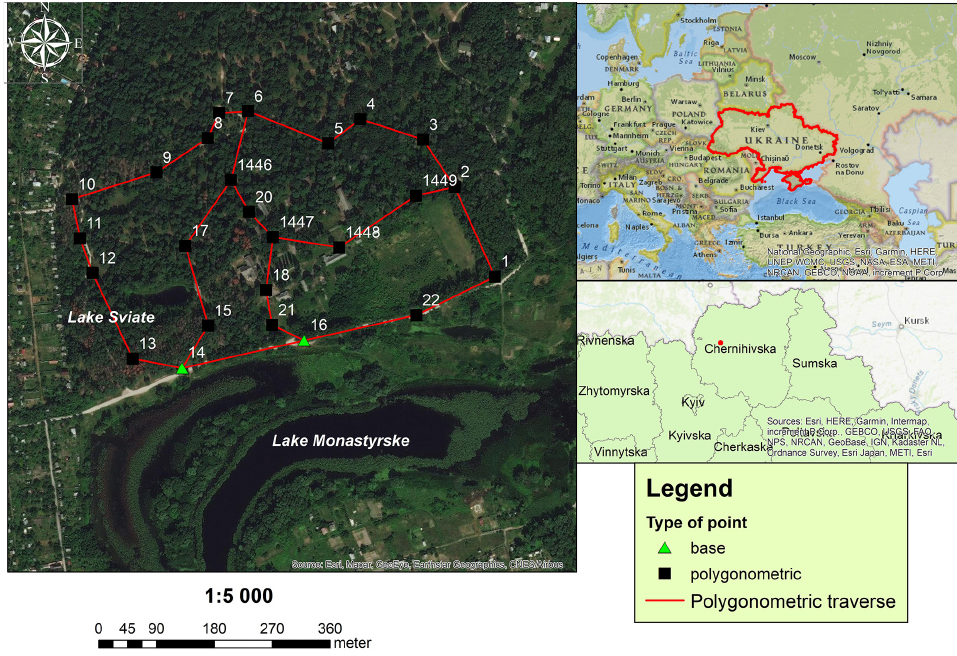
Figure 1. Location of polygonometry points on the territory of the site